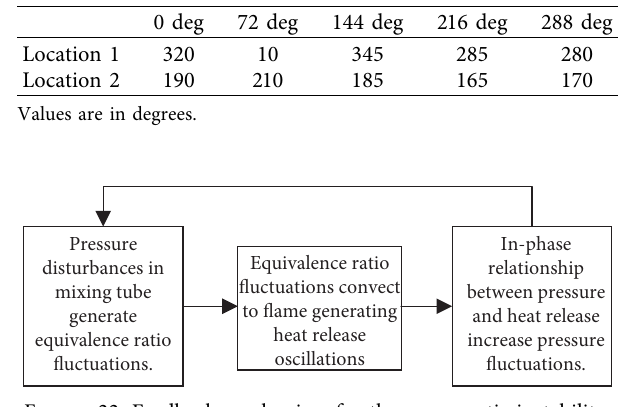
Figure 21: No PIM (a) and PIM (b) Rayleigh index results. Average velocity vectors overlaid. Table 2: Phase difference between injection site fluctuations and heat release locations in combustor for different temporal points during the instability.